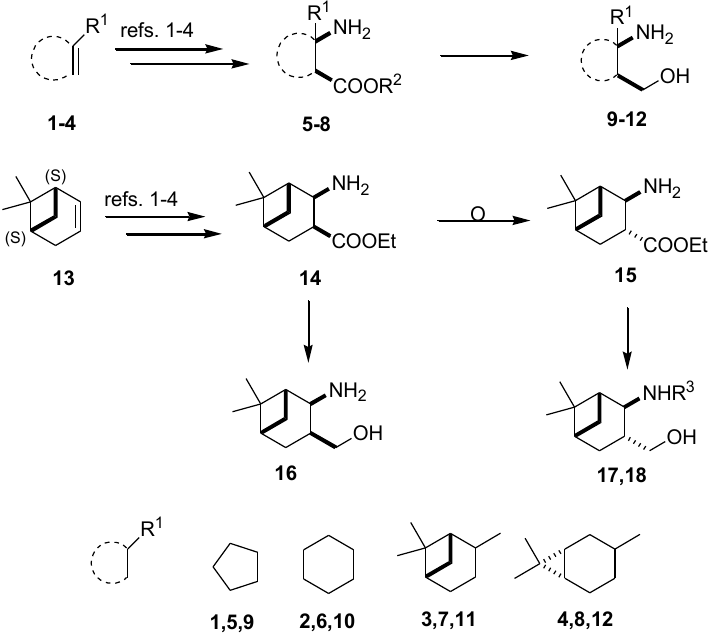
Figure 1. Synthesis of 1,3-amino alcohol starting